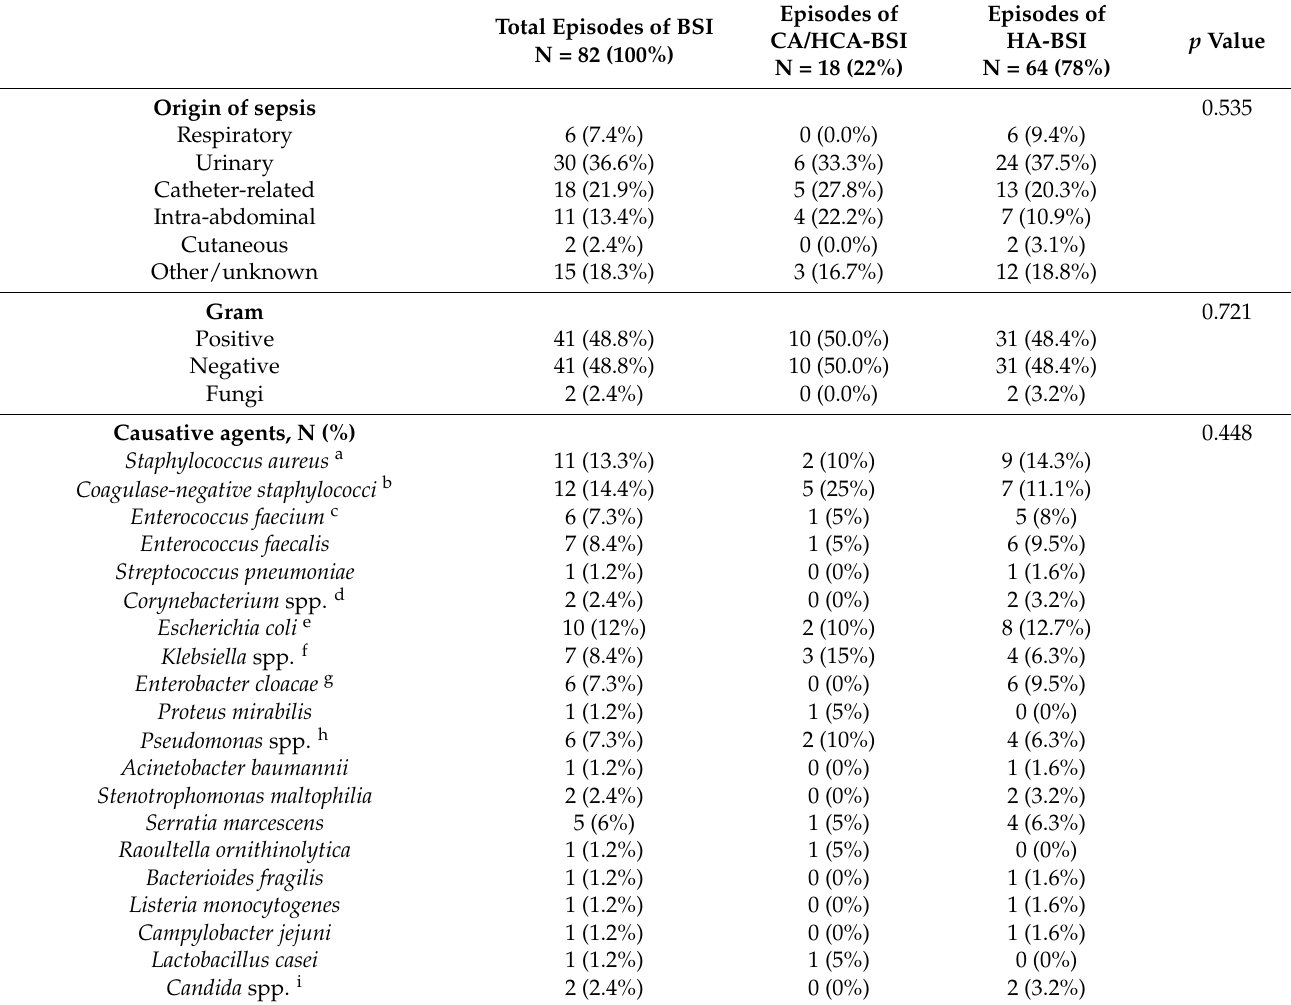
Table 3. Clinical and microbiological characteristics of 82 bacteremic